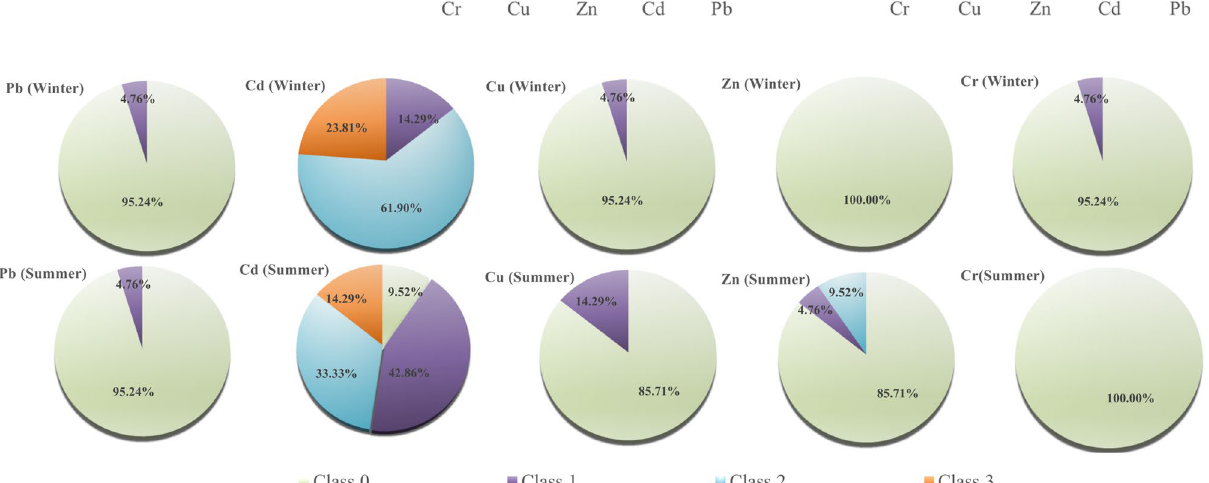
Fig. 4 Contribution of Geo-accumulation